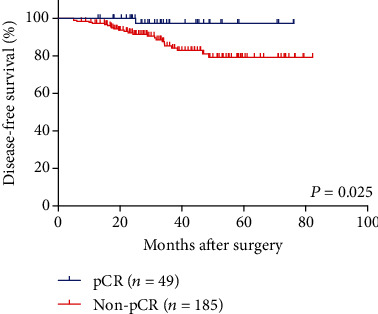
DFS in patients with pCR and non-pCR.